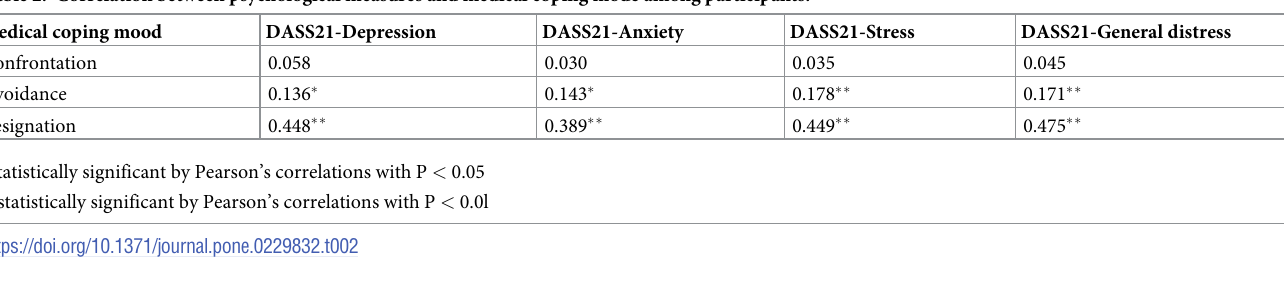
Table 2. Correlation between psychological measures and medical coping mode among participants.